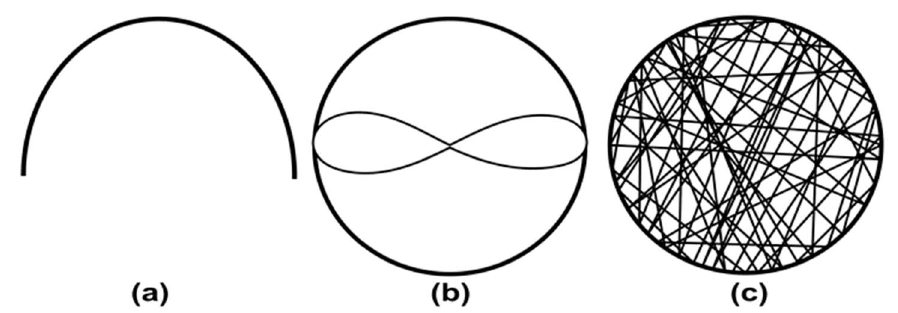
Figure 6. Sample motion in random position machine. ( a ) Both motors at the same speed. ( b ) motor speed rate 1:2. ( c ) Both motors are at random speeds. (Adapted with permission from [73]. Copyright 1992, The Botanical Society of Japan)